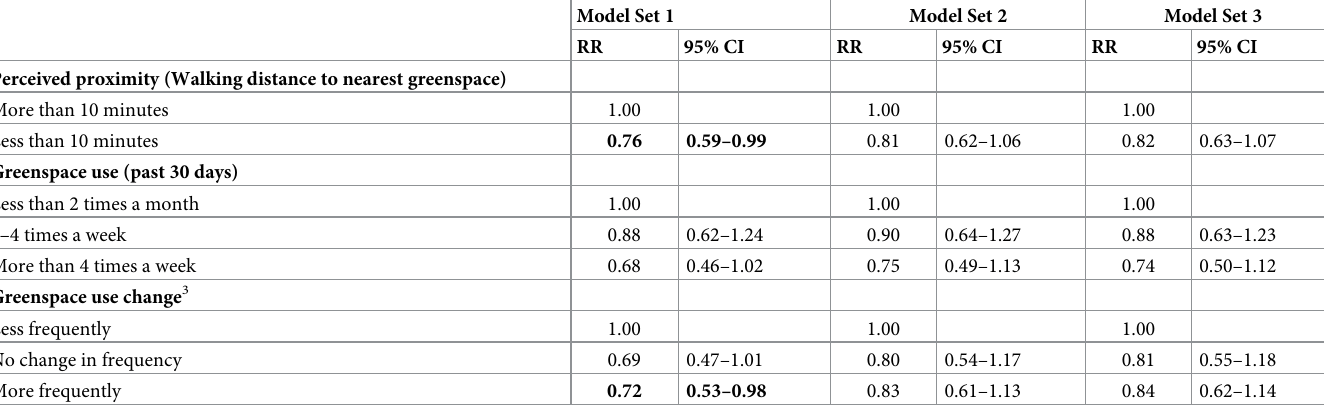
Table 5. Estimates of association between the greenspace measures and higher levels of perceived stress 1,2